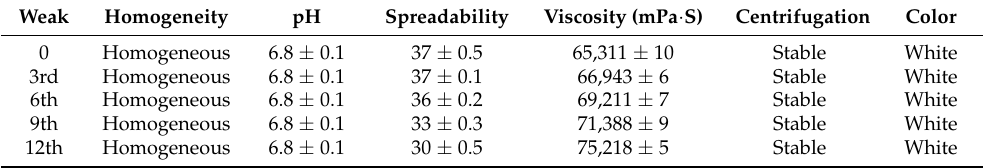
Table 9. Stability of nanoemulgel at 8 ◦